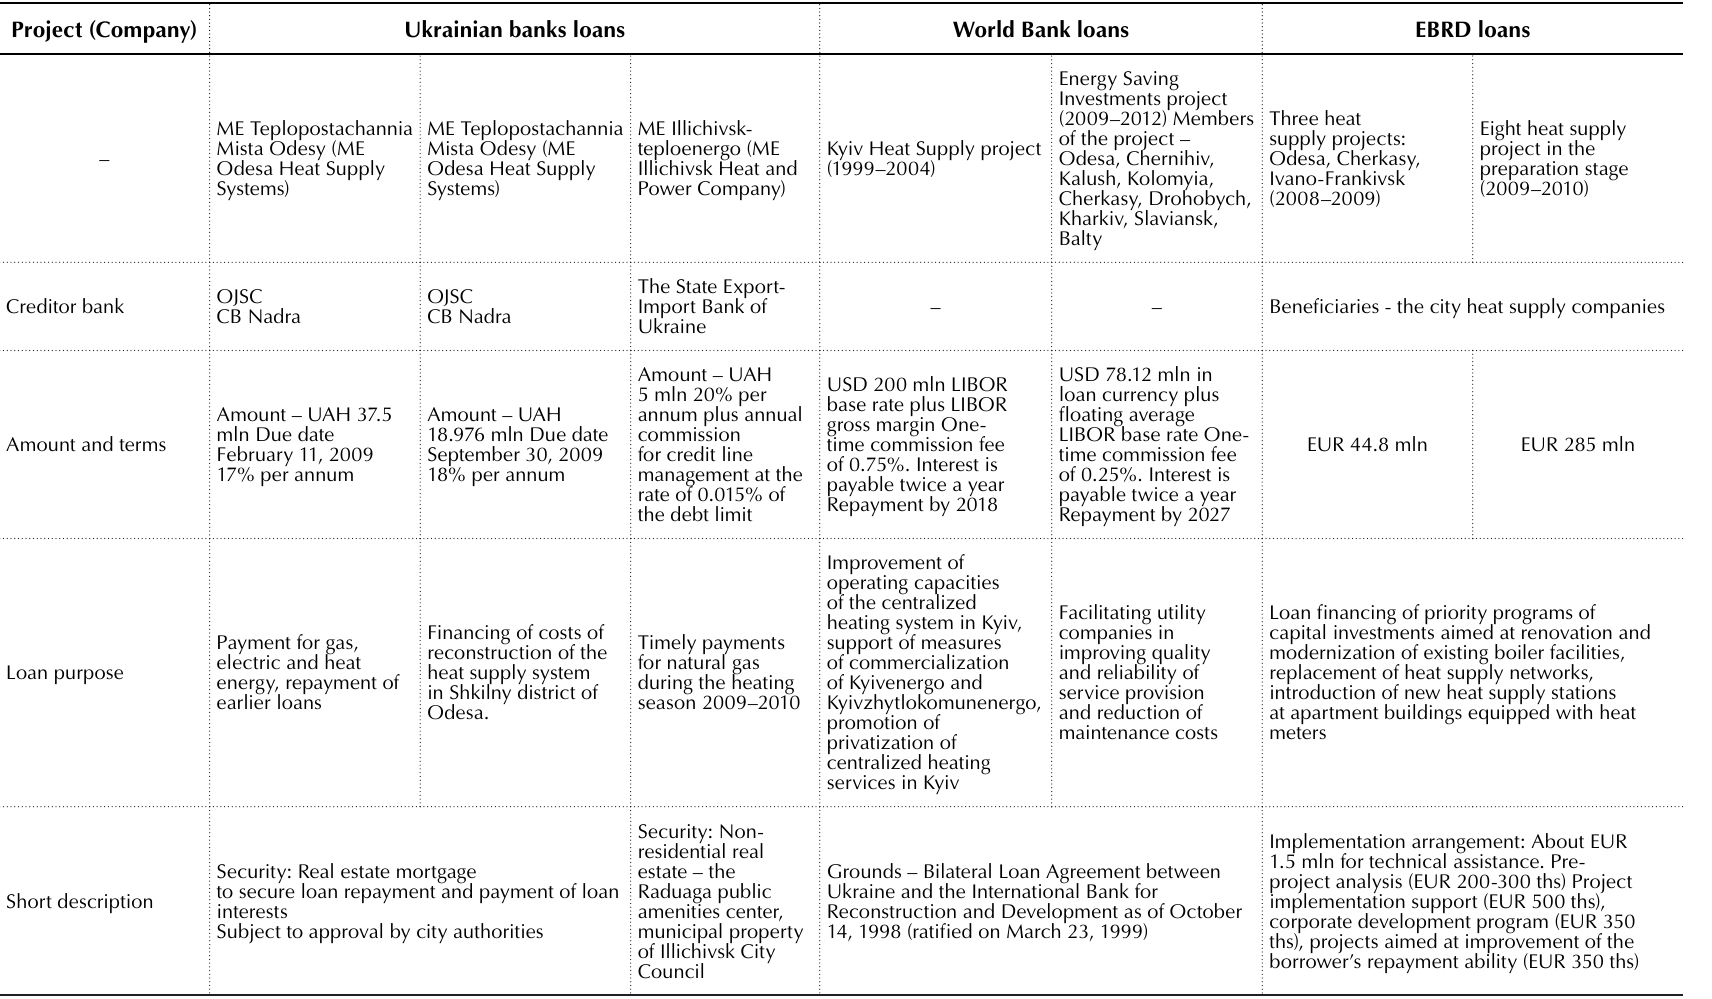
Table A. Case study of participation of credit institutions in public-private partnership